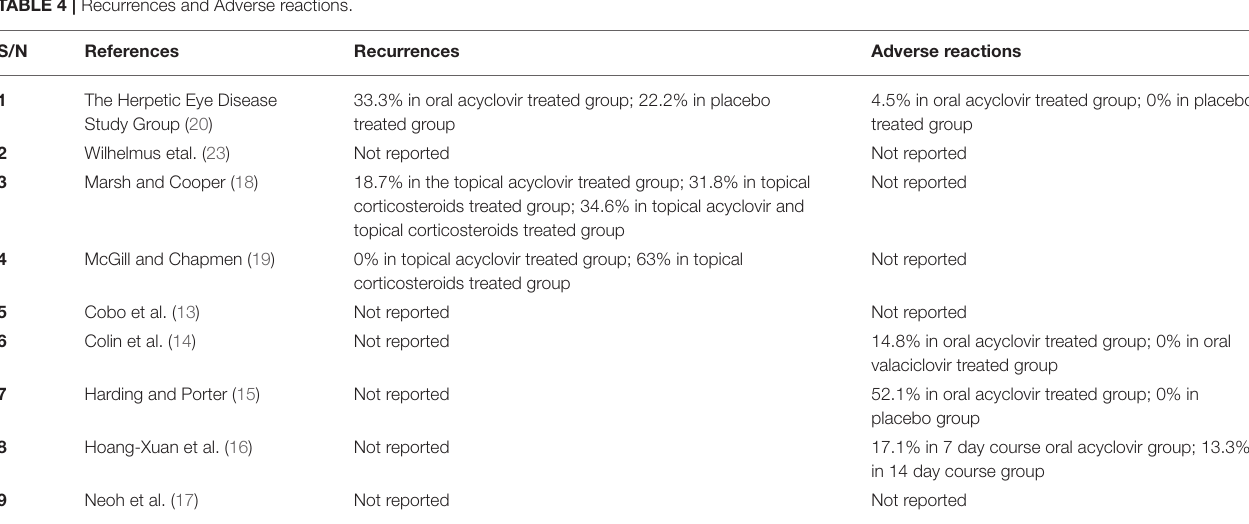
TABLE 4 | Recurrences and Adverse